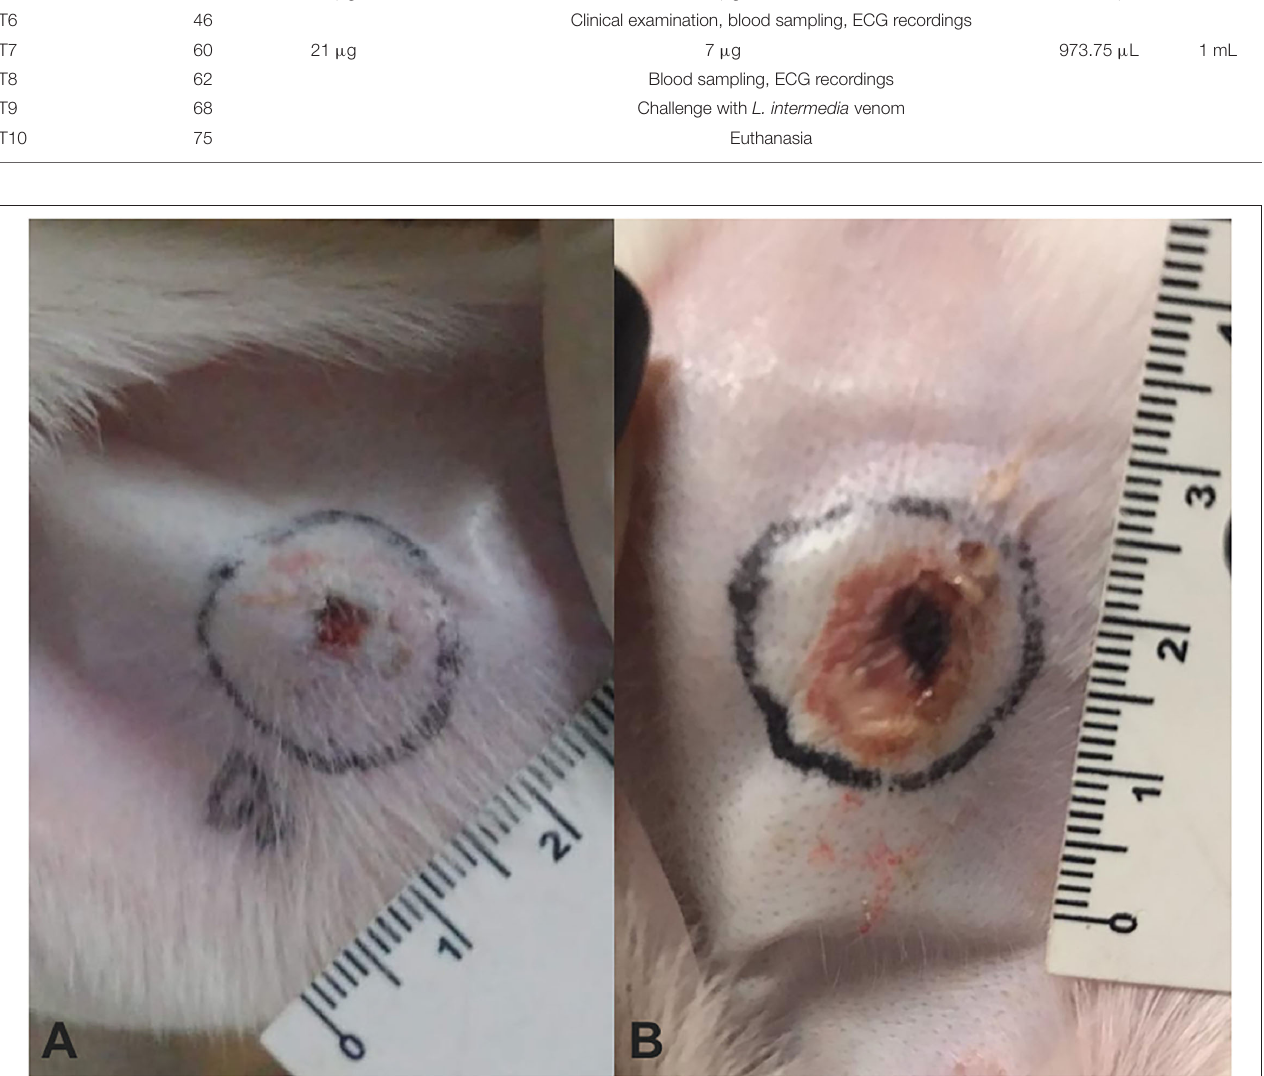
FIGURE 1 | Measurement of dermonecrotic lesions after challenge using a 7 µ g of Loxosceles intermedia (L. intermedia) venom in rabbits that have undergone immunization protocol using venom from Loxosceles spp. (A) Rabbit V1 from venom group (VG) showing a minimal lesion with absence of necrosis. (B) Rabbit C1 from control group (CG) showing a larger lesion area accompanied by necrosis.